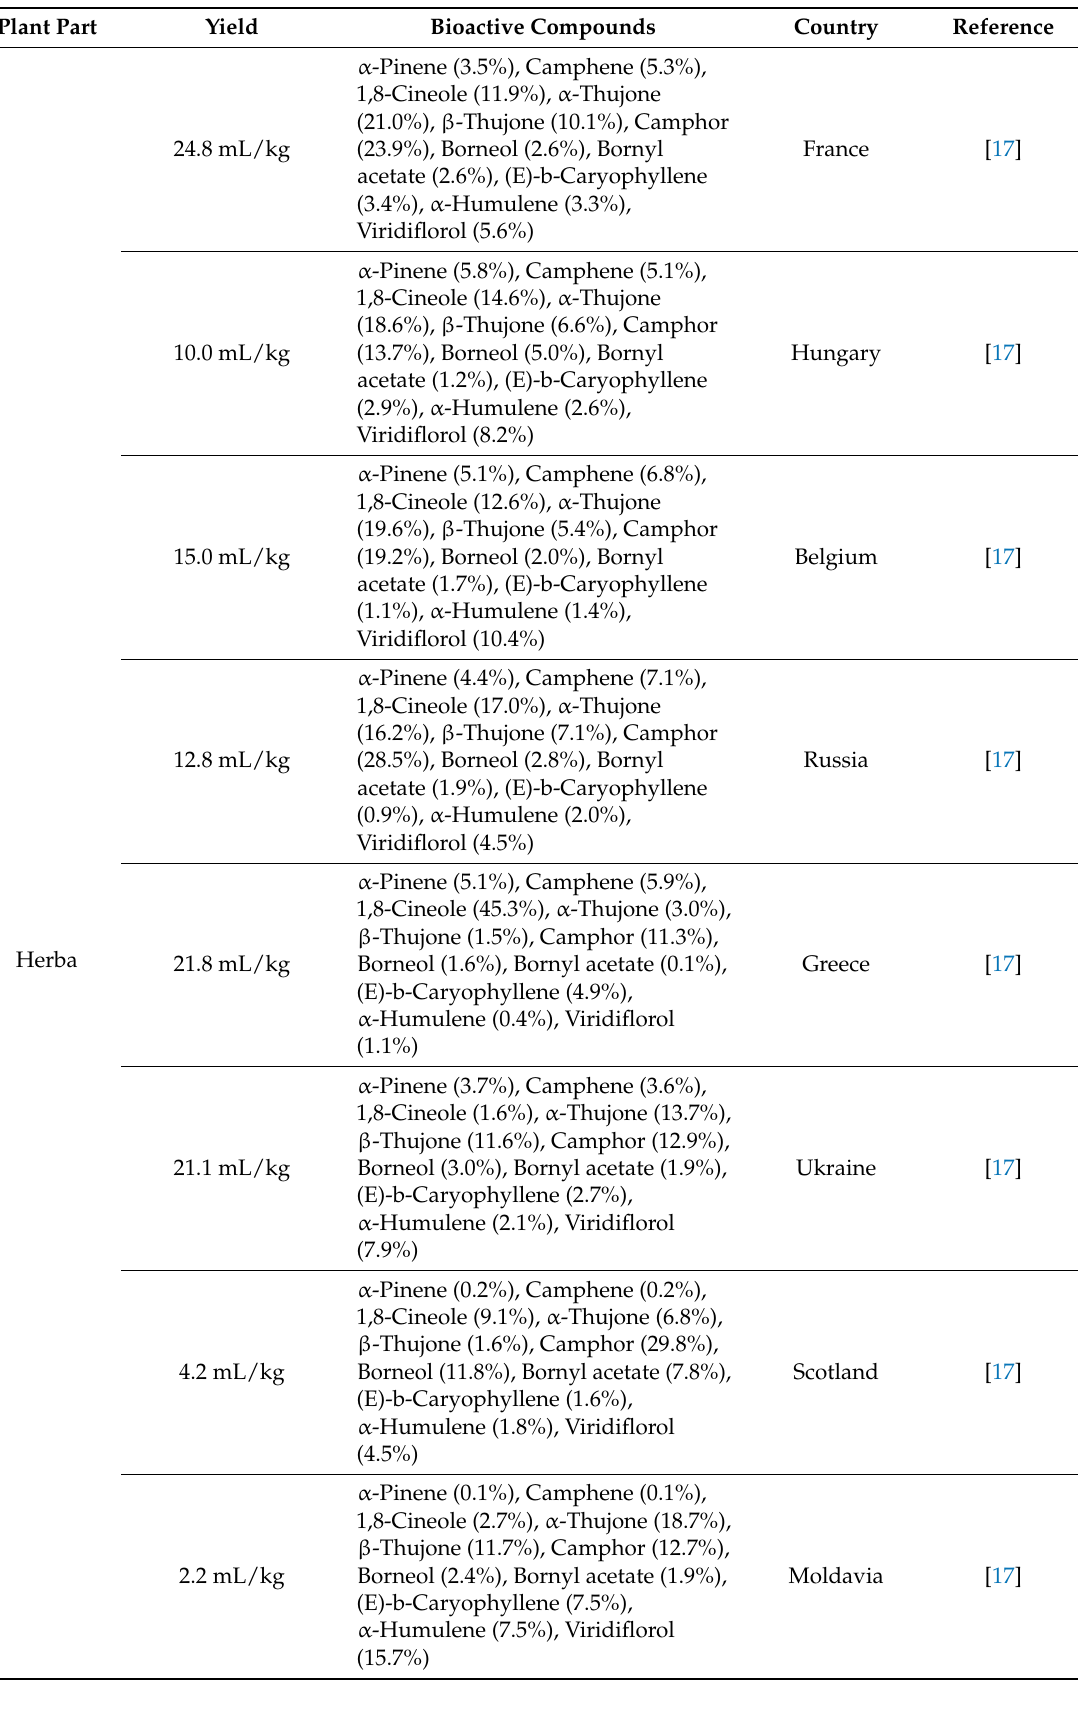
Table 1. The composition of bioactive compounds found in sage extracts obtained by hydrodistillation. Plant